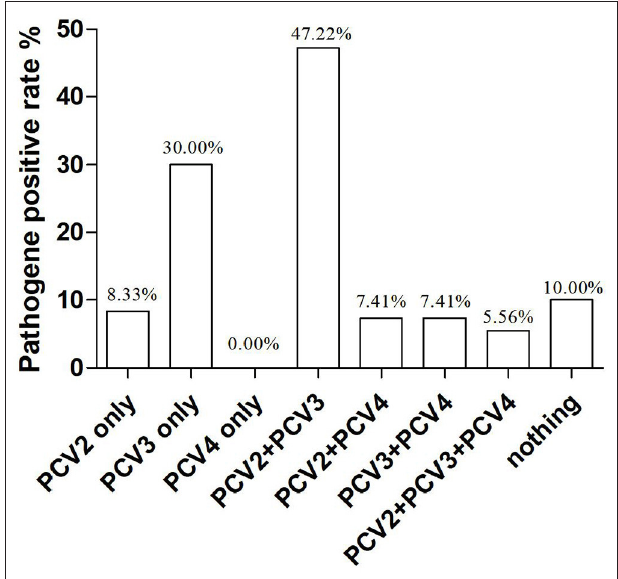
FIGURE 2 | Proportions of major pathogens in PCR-positive porcine samples.